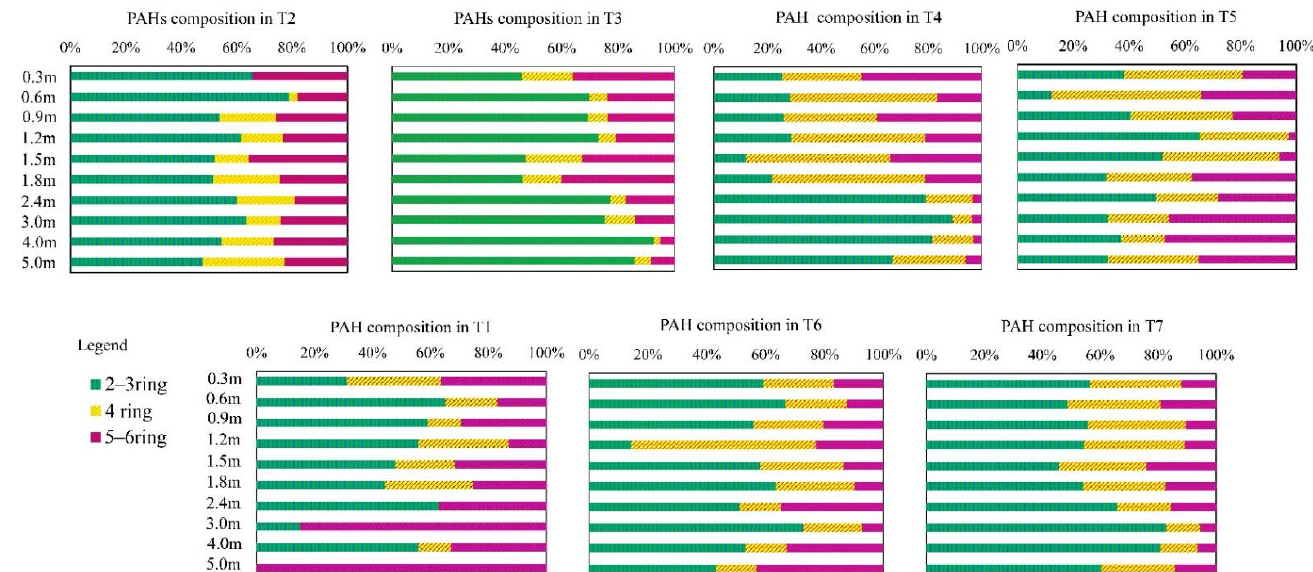
Figure 3. Vertical fractions of PAHs with different ring numbers in the soil of the legacy site.